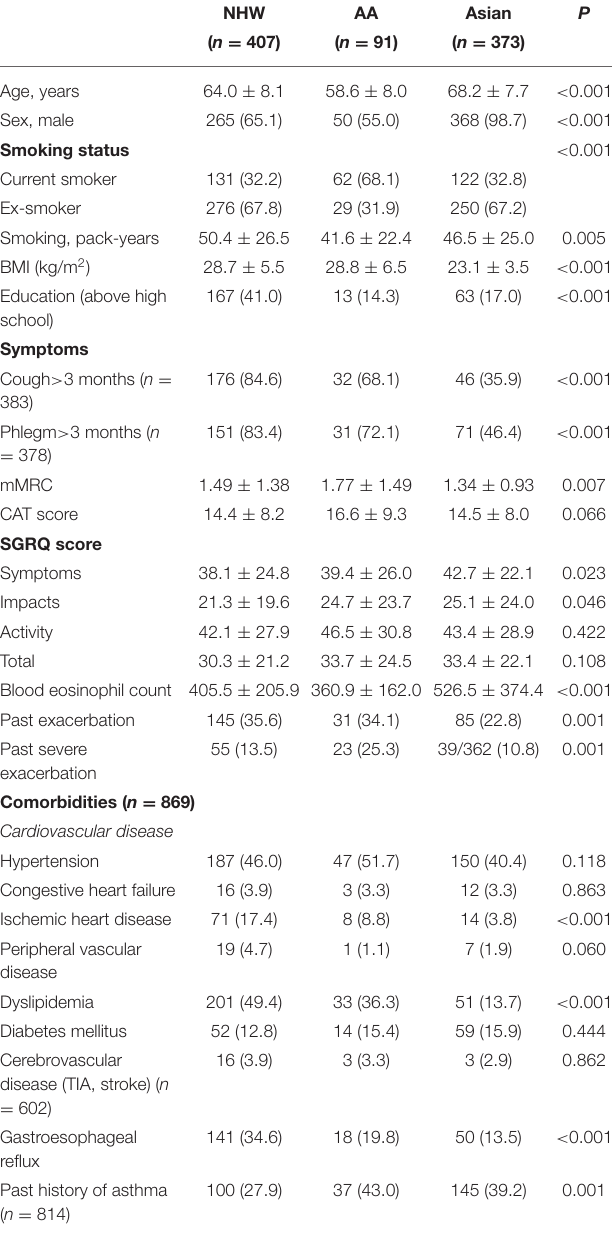
TABLE 2 | Baseline pulmonary function test parameters of patients with ACO by race and ethnicity. NHW AA